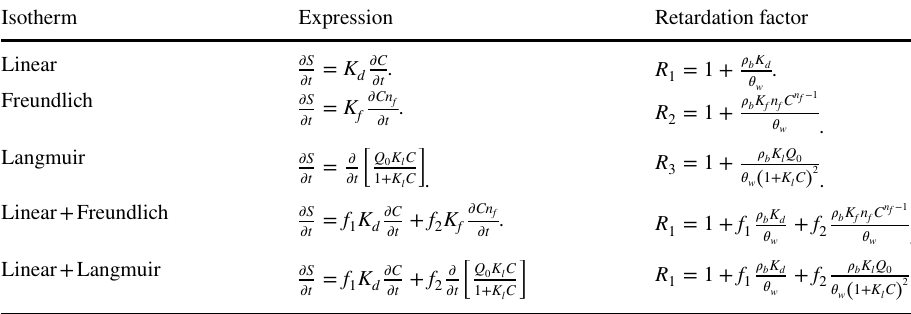
where C is the concentration of ammonium or nitrate nitrogen in aqueous phase (mg/l); S is the concentra- tion of ammonium or nitrate nitrogen in solid phase (mg/mg); ρ b is the soil bulk density (g/cm 3 ); k d is the linear partitioning coefficient for corresponding nitrogen species (l/mg); K f is Freundlich adsorption con- stant (l/mg); n f is Freundlich isotherm constant; Q 0 is the sorption capacities of sorbent (mg/mg); K l is the Langmuir adsorption constant (l/mg); and f 1 and f 2 are